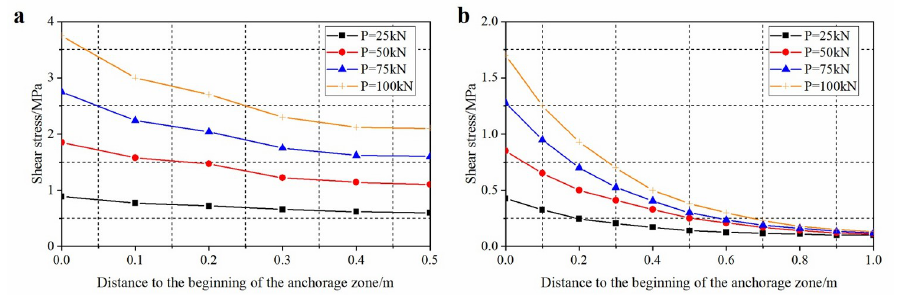
Fig 12. Shear stress distributions of anchorage zone under different pull-out forces in laboratory test. (a) anchorage length is 0.5 m; (b) anchorage length is 1.0